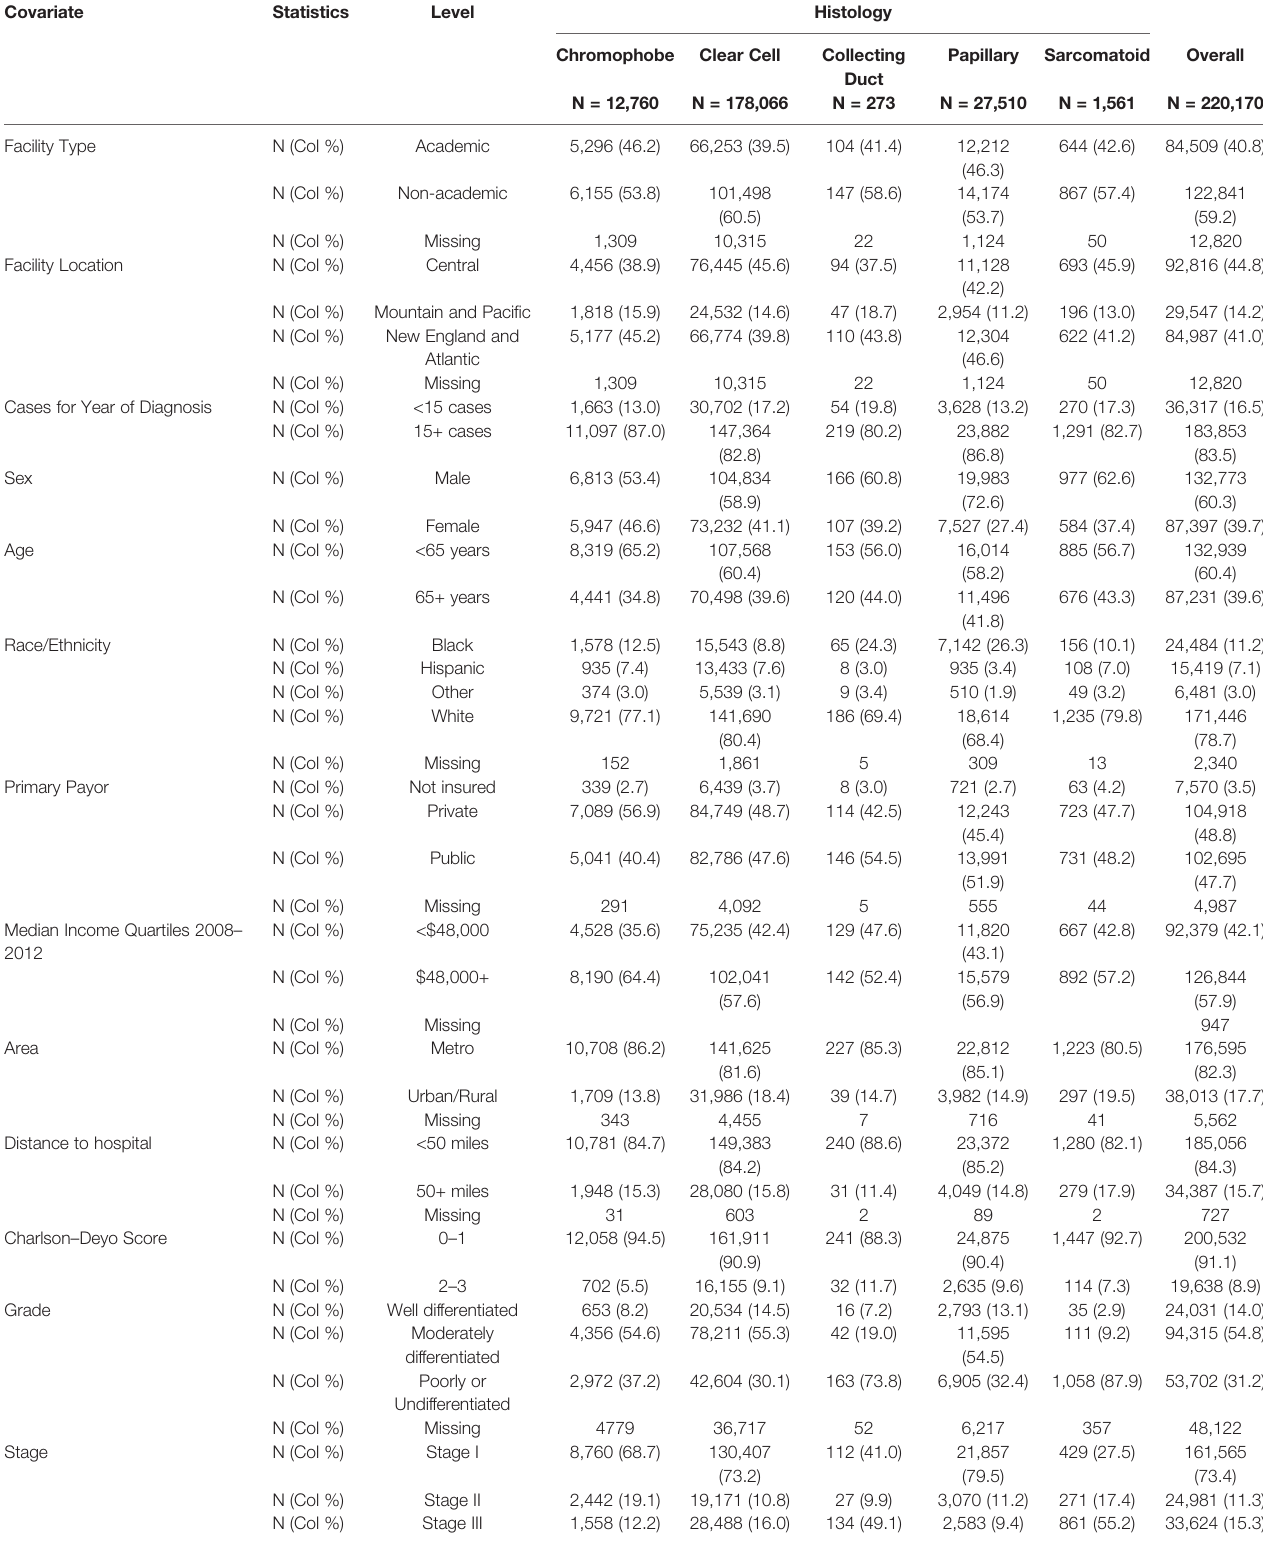
TABLE 1 | Patient demographics and